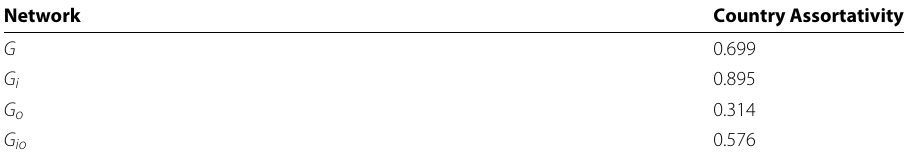
Table 6 Country attribute assortativity for G , G i , G o , and G io . Nodes in these networks that were associated with more than one country (or with no country at all) were not included in the analysis Network Country Assortativity G 0.699 G i 0.895 G o 0.314 G io